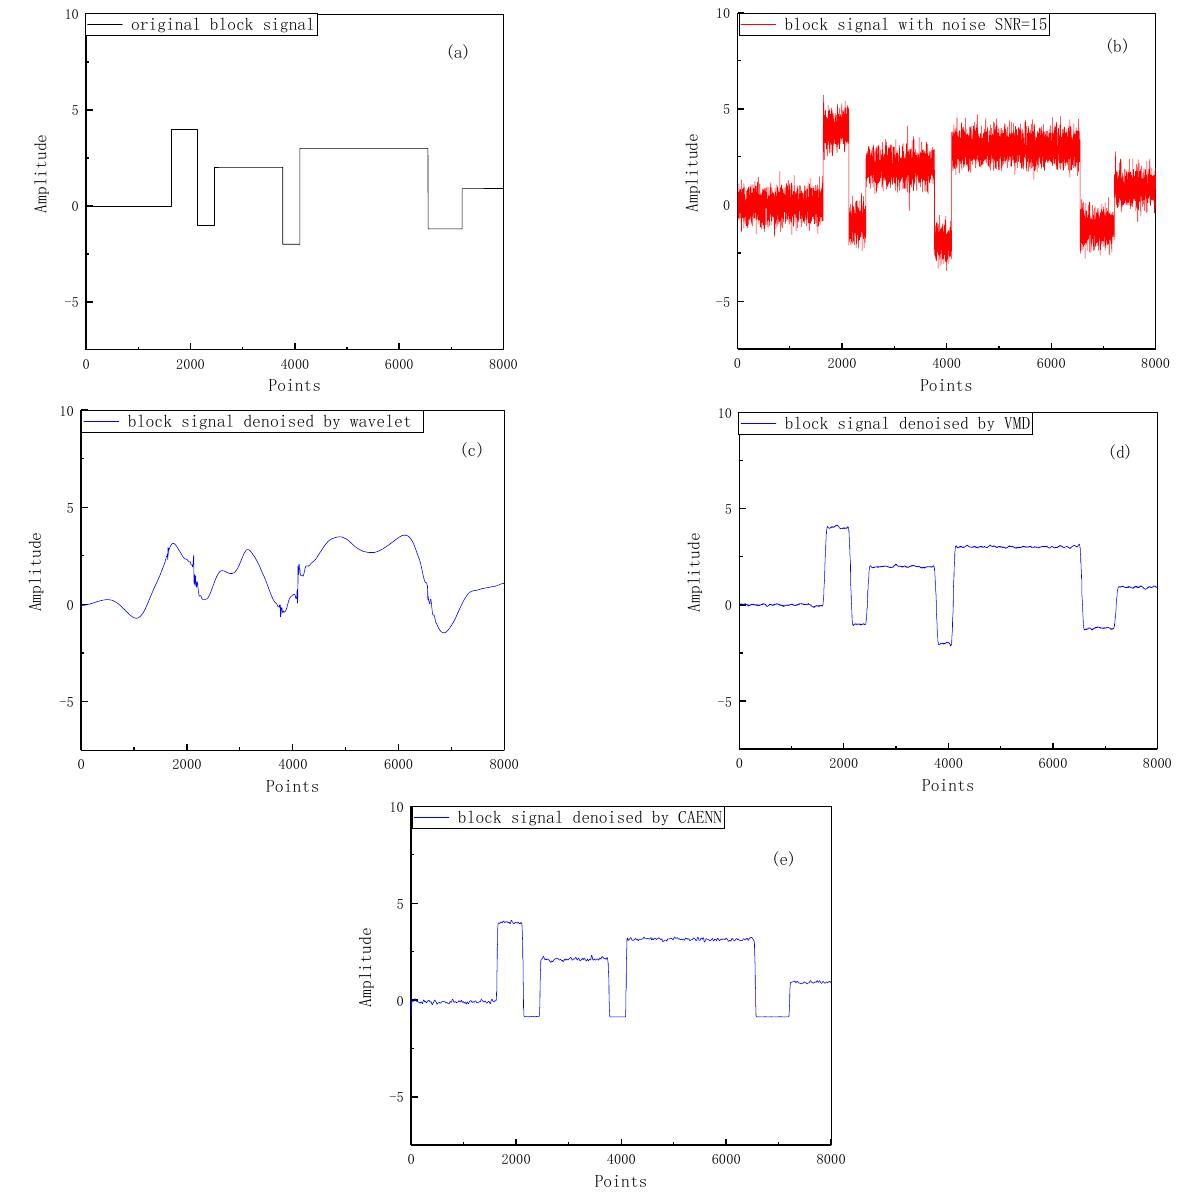
Figure 7. The simulated noise reduction effects of Block signals. ( a ) the original block signal, ( b ) the block signal with SNR = 15 noise, ( c ) the signal processed by the wavelet threshold method, ( d ) the signal processed by the VMD method, ( e ) the signal processed by CAENN method.